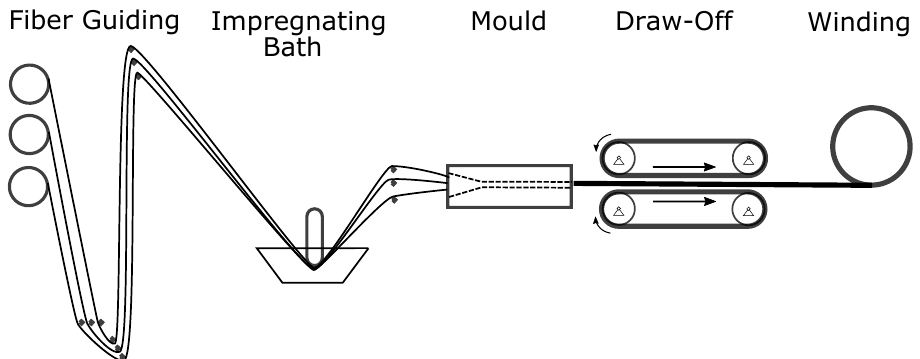
Figure 1. Schematic illustration of the